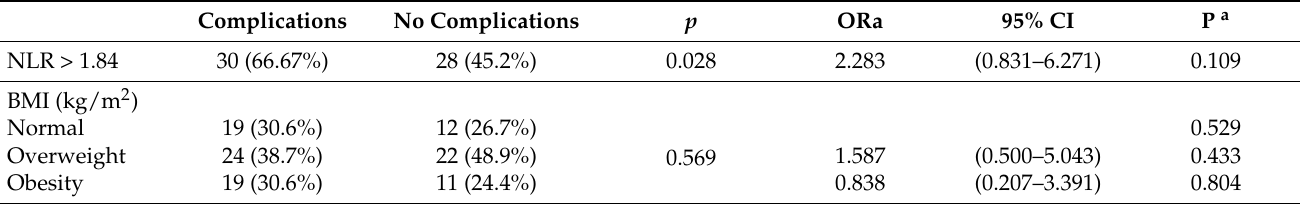
Table 4. Multivariate analysis adjusted by age, sex, pathological stage, and